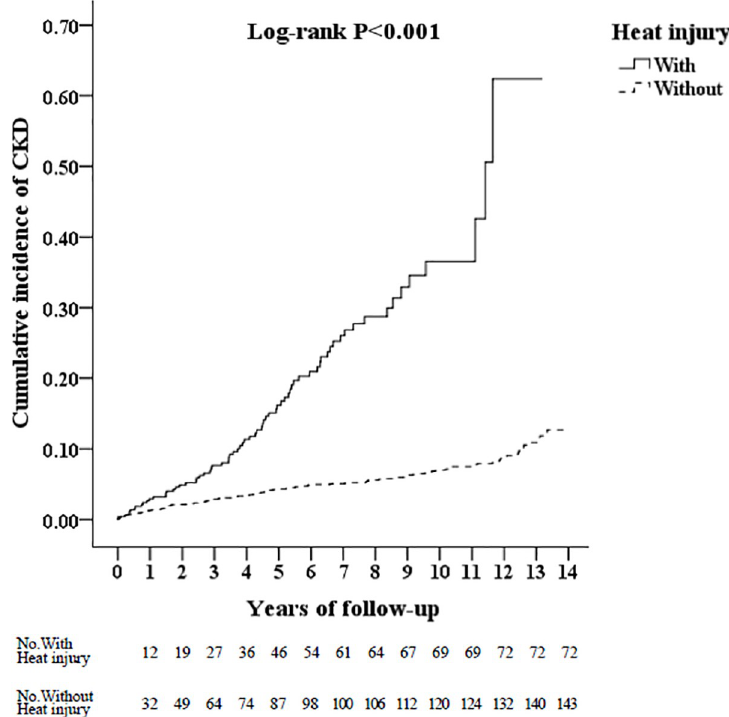
Fig 2. Kaplan-Meier curve for cumulative risk of chronic kidney disease in patients with and without heat injury. CKD: Chronic kidney disease.